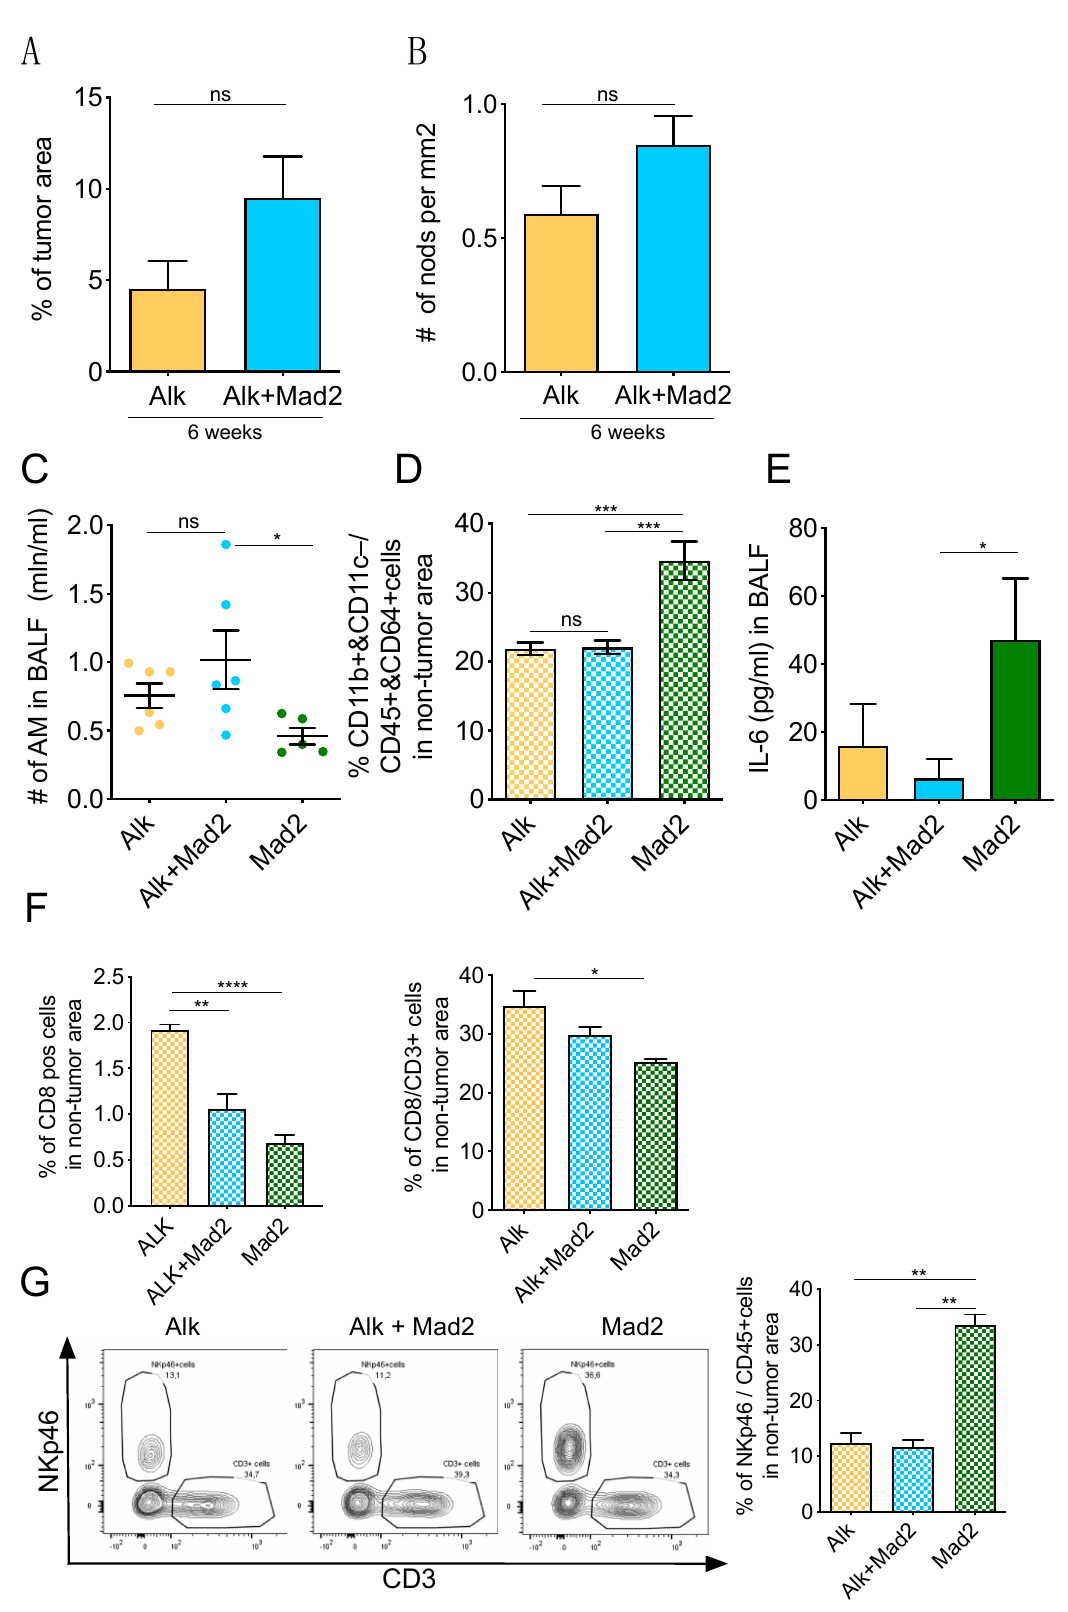
Figure 5. Characterization of Alk and Alk+Mad2 mice 6 weeks after tumor initiation. ( A ) Percentage of tumor area/total lung area on H&E-stained cross-sections of Alk and Alk+Mad2 mice. ( B ) Number of nodules per mm 2 in Alk and Alk+Mad2 mice. ( C ) Number of alveolar macrophages in the bronchoalveolar lavage fluid of Alk, Alk+Mad2, and Mad2